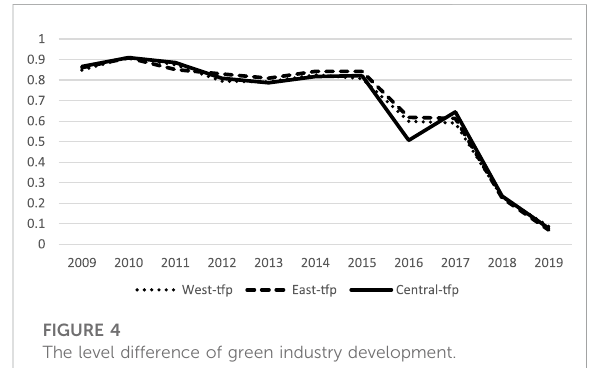
FIGURE 4 The level difference of green industry